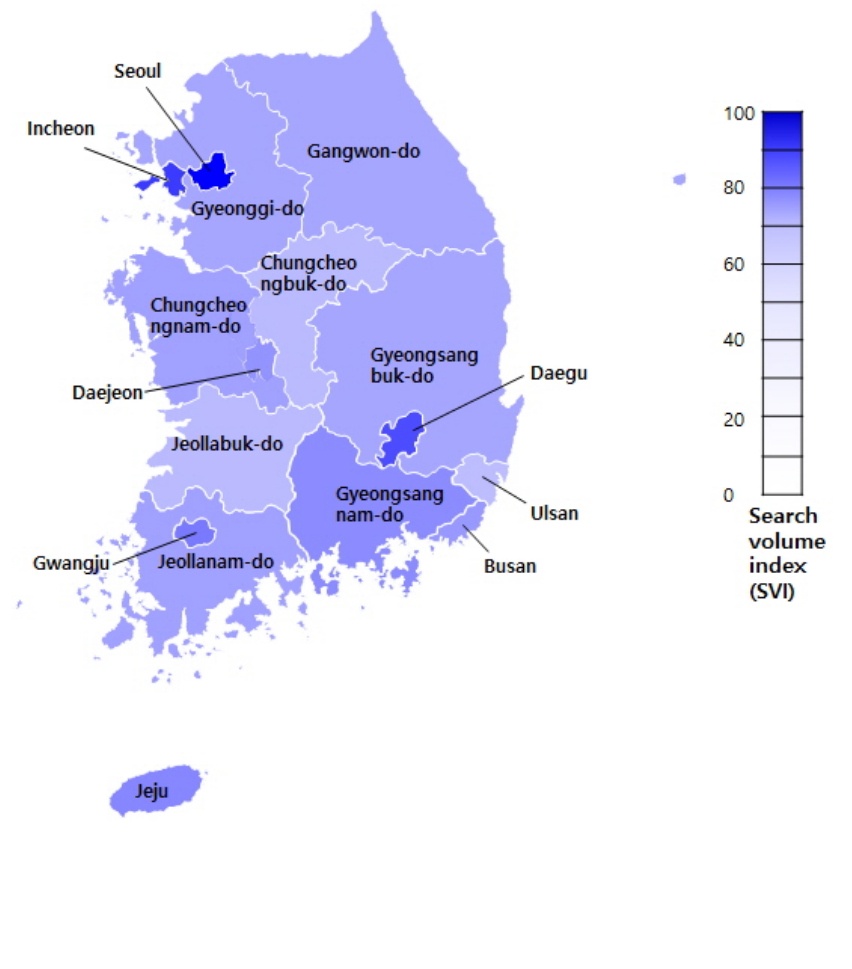
Figure 2. Regional trends in internet searches for